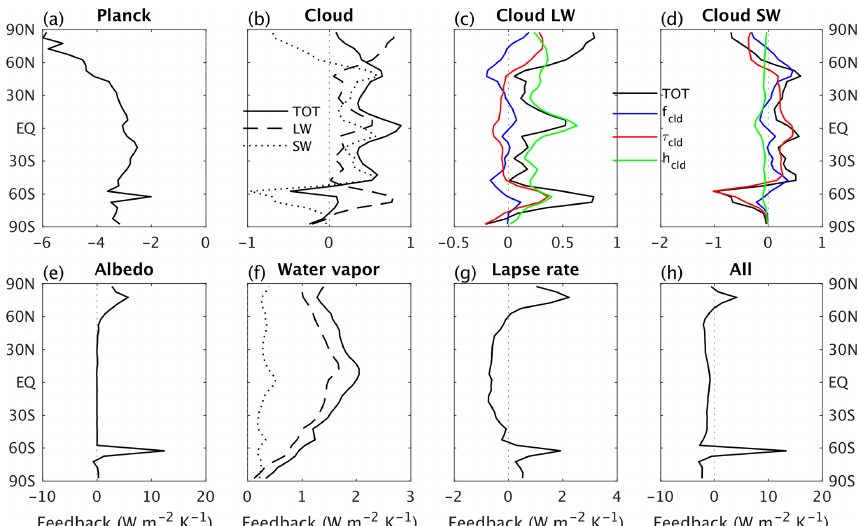
Figure 23. Zonal mean feedback parameters for CLIMBER-X. The total feedbacks (black solid lines) are further separated into contributions from longwave (LW, dashed black lines) and shortwave (SW, dotted black lines) radiation. Cloud feedbacks are additionally explicitly decomposed into LW and SW in panels (c) and (d) , with the different colours representing feedbacks from changes in cloud fraction (blue), cloud optical thickness (red), and cloud top height (green).